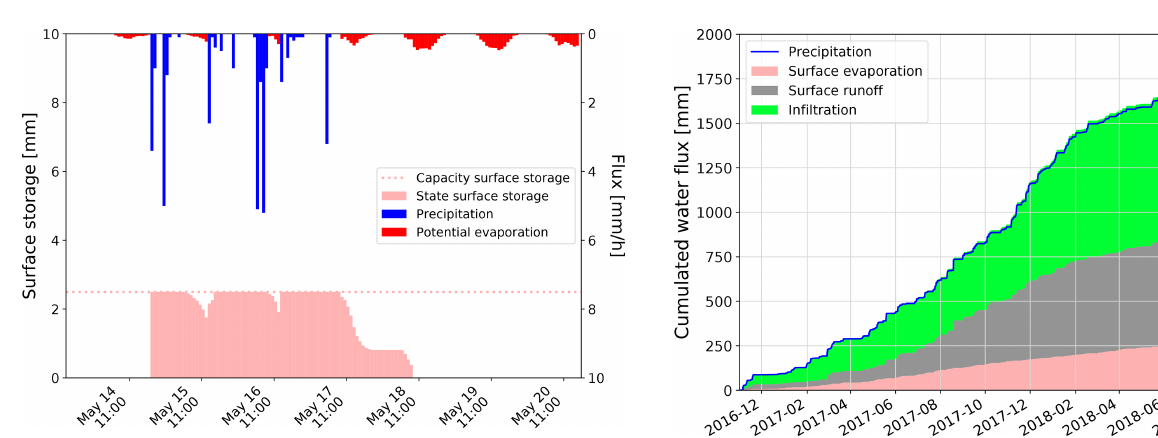
Figure 5. Cumulative surface water balance of plot CP14 over the entire study period.